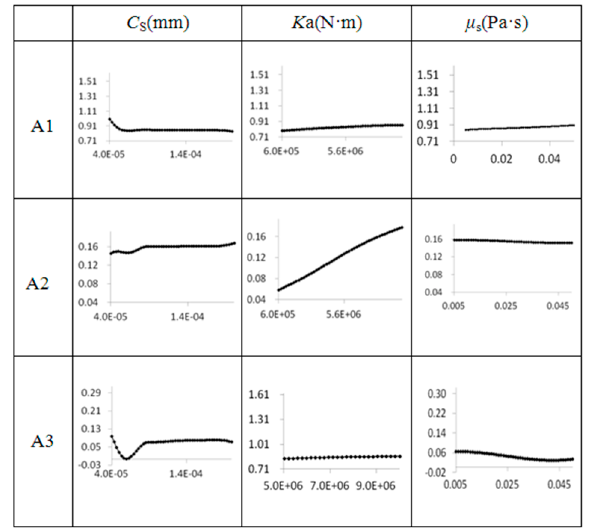
Figure 12. E ff ect of SFD design parameters on the amplitude of the fundamental, 2 × fundamental and Figure 12. Effect of SFD design parameters on the amplitude of the fundamental, 2× fundamental and 3 × fundamental frequency of the system with misalignment 3× fundamental frequency of the system with misalignment fault.